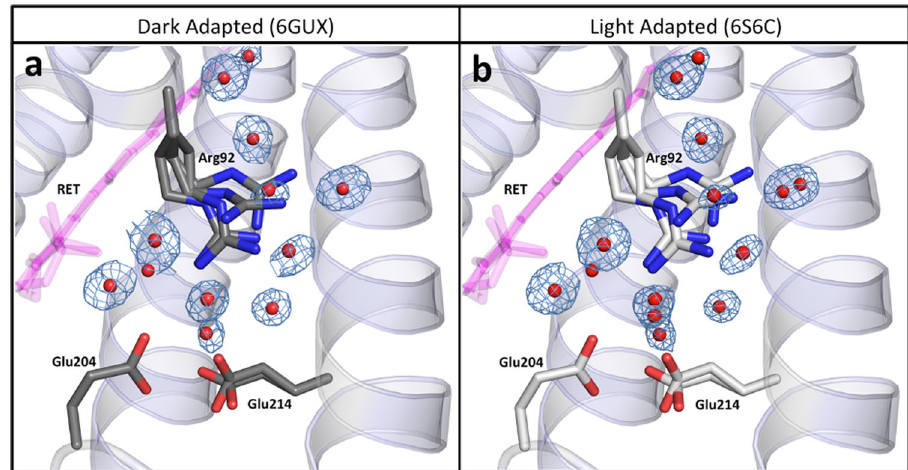
Fig. 5 Structures of the Proton Release Complex (PRC) of AR3. Glu204, Glu214 and the associated network of H-bonded water molecules in DA (6GUX [http://doi.org/10.2210/pdb6GUX/pdb]) ( a ) and LA AR3 (6S6C [http://doi.org/10.2210/pdb6S6C/pdb]) ( b ). Selected amino acid sidechains are shown in stick representation with atoms colored using the CPK convention. Water molecules are shown as red spheres and retinal is colored pink. The 2 F obs – F calc electron density maps (blue mesh) around the water molecules are contoured at 1.2 σ .